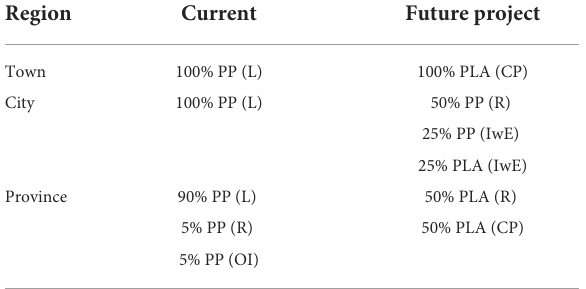
TABLE 2 Development scenarios (OI, Open Incineration; IwE, Incineration with Energy recovery; L, Landfill; R, Recycling; CP, Composting).